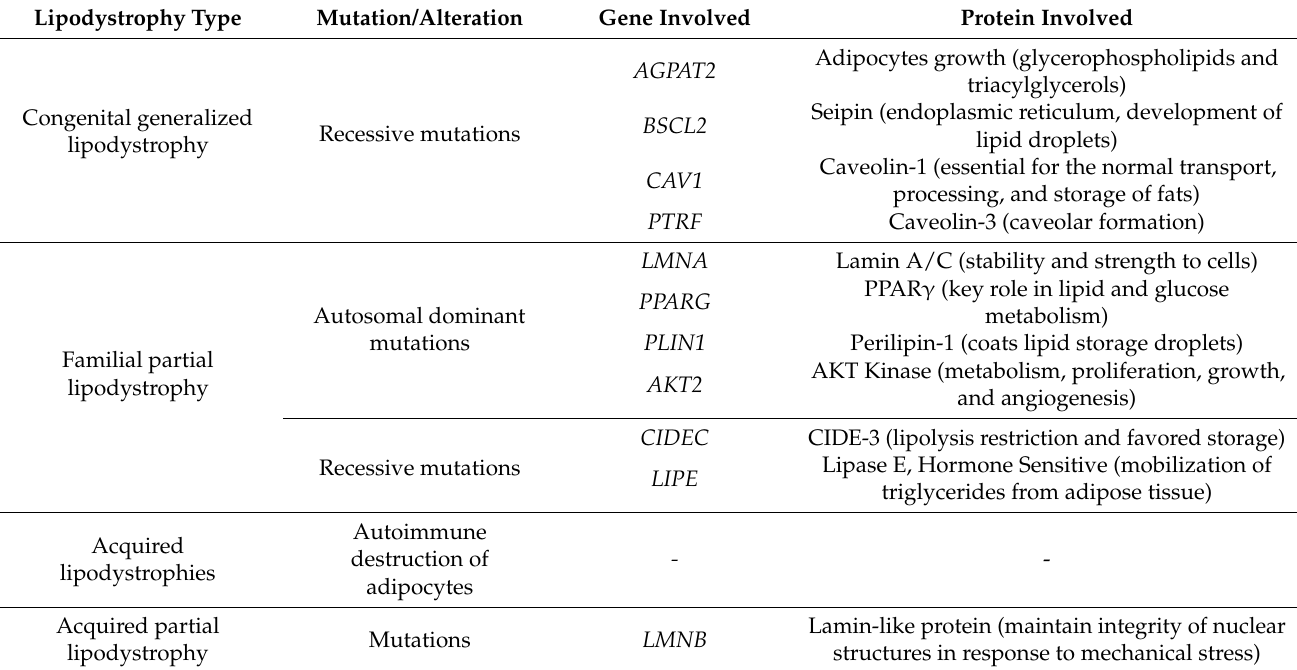
Table 1. Description of lipodystrophy types, kinds of damage, genes, and proteins involved